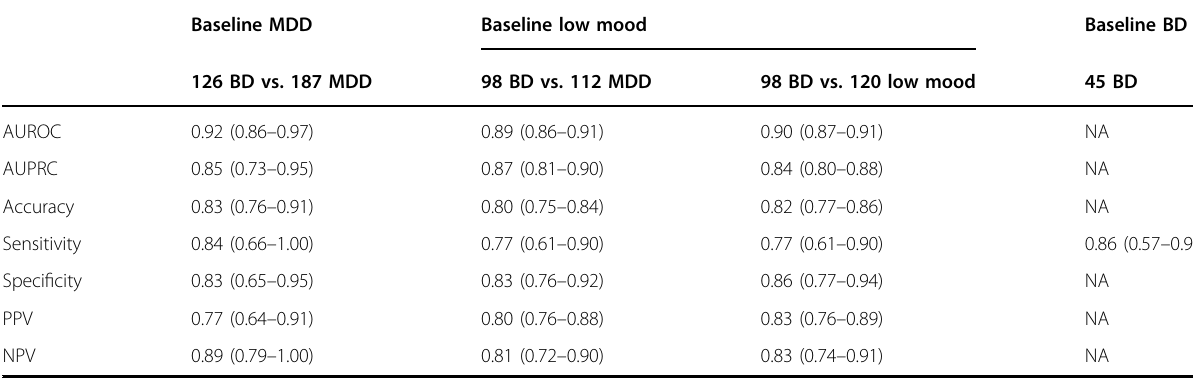
Table 2 Out-of-fold model performance in the primary and secondary